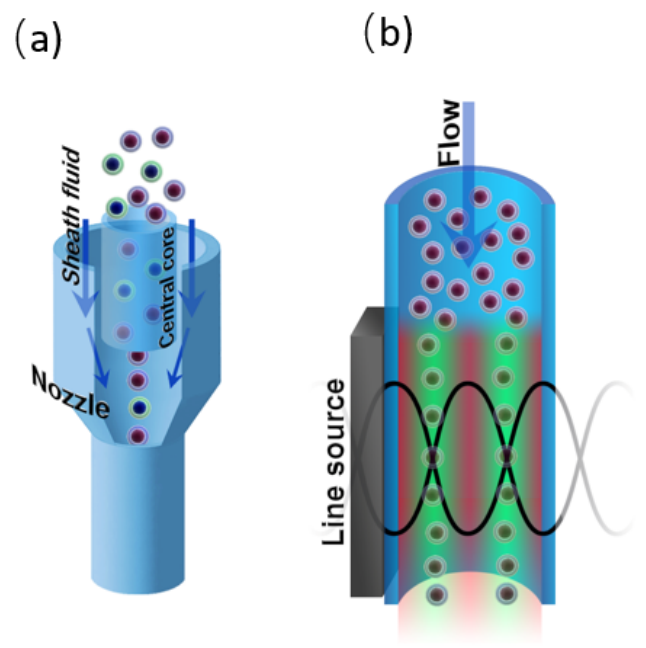
Figure 8. ( a ) Hydrodynamic and ( b ) acoustic focusing in a microfluidic